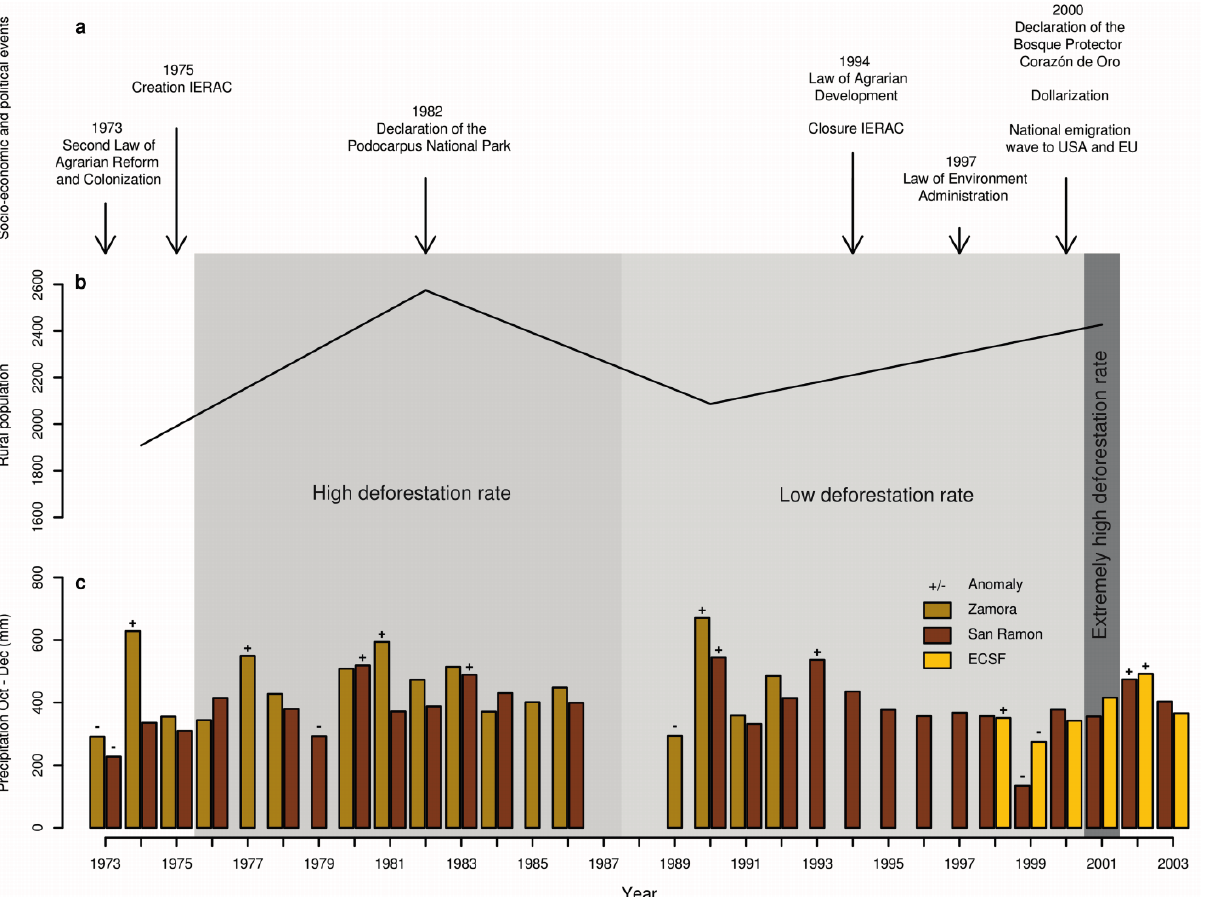
Figure 12. Potential drivers ( a – c ) responsible for the changes in the deforestation level (gray tones in the background) derived from the remote sensing analysis in the study area. ( a ) Sociopolitical and economic events; ( b ) absolute rural population number for the three parishes acquired from the Ecuadorian Instituto Nacional de Estadística y Censos (INEC); and ( c ) precipitation amount in the driest months (October to December) and anomalous years in the period between 1966 and 2011, obtained and compiled from the data collected by three meteorological stations within the area of investigation. The ECSF station, located at 1960 m a.s.l., collected data since 1998 [104]; the San Ramón station (1820 m a.s.l.) from the Empresa Eléctrica Regional del Sur S.A. (EERSSA) provided data from 1964 until 2008; and the Zamora station (970 m a.s.l.) from the Instituto Nacional de Meteorología e Hidrología (INAMHI) collected data from 1964 until 1993. The anomalous years were calculated as ≥ +1 or ≤ − 1 standard deviation ( σ ) based on all data